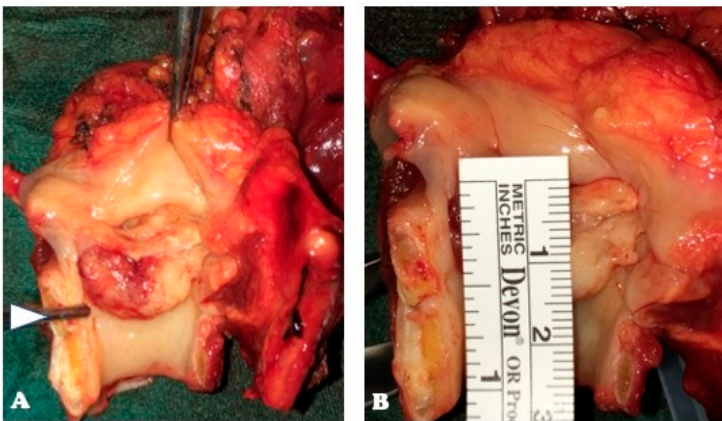
Figure 8. Specimen of OPHL type IIIa + CAU: glottic -subglottic LC showing infraglottic extension >10 mm: ( A ) Tumor shows an evident subglottic extension, clearly reaching above the level of the cricoid plate (white arrow); ( B ) Tumor spreads infraglottically 15 mm from the free edge of the TVC midline.